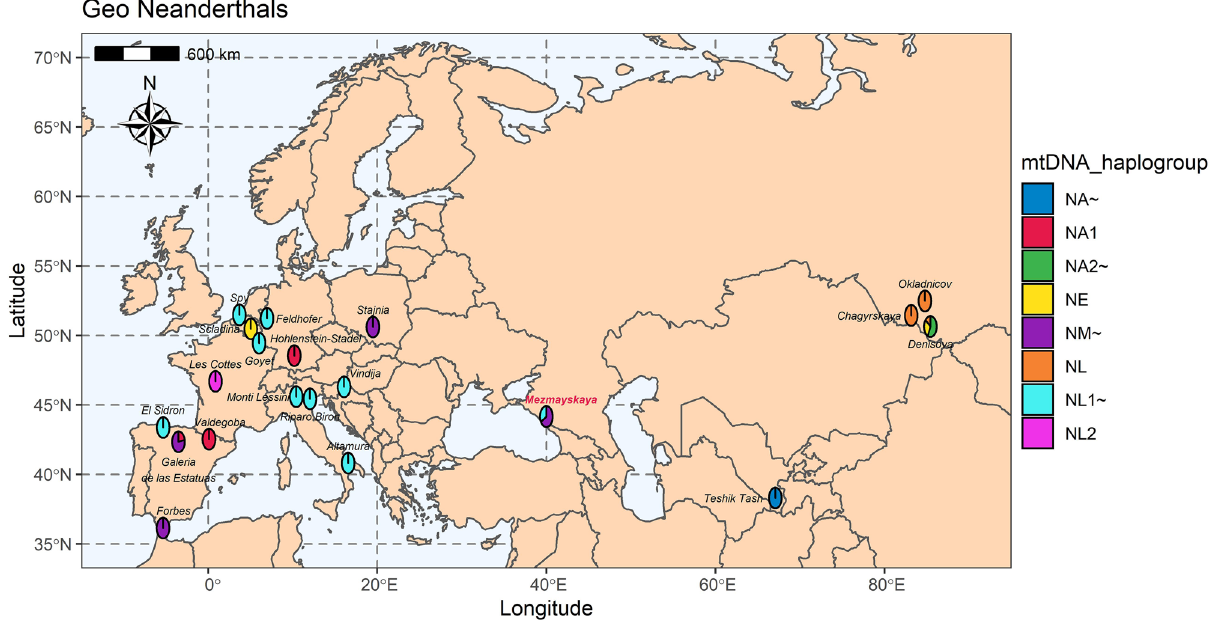
Figure 1. Eurasia map showing the locations of the Neanderthal samples used in the analysis. Mezmaiskaya Cave is typed in red. Neanderthal haplogroups (see Results, Supplementary Fig. S10) are indicated at each location by coloured sectors, and large haplogroups combine subsequent branches: NA2 ~ includes NA2 and NA2a; NM1 ~ includes NM1, NM1a, NM2; NL1 ~ includes NL1a1, NL1a2a, NL1a2b1, NL1a2b. NA ~ Teshik- Tash individual. The figure was generated using ggplot2 (https:// ggplo t2. tidyv erse. org), ggspatial (https:// github. com/ paleo limbot/ ggspa tial), rnaturalearth (https:// github. com/ ropen sci/ rnatu ralea rth), rnaturalearthdata (https:// github. com/ ropen sci/ rnatu ralea rthda ta), scatterpie (https:// CRAN.R- proje ct. org/ packa ge= scatt erpie) and sf (https:// github. com/r- spati al/ sf) packages for